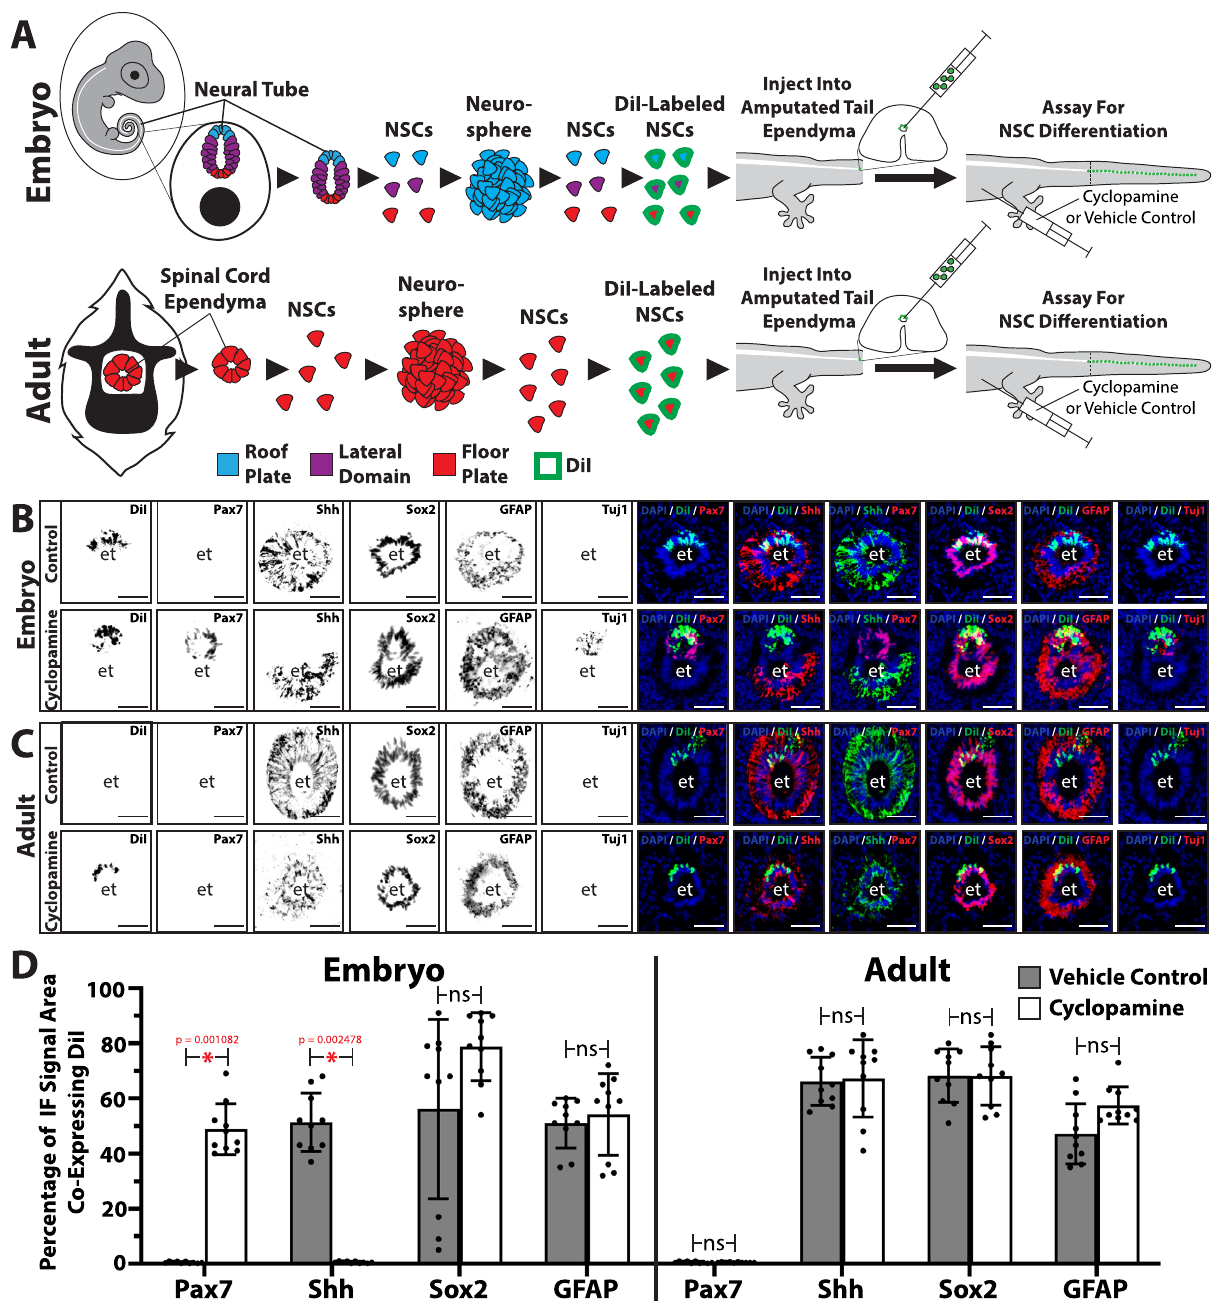
Fig. 6 Embryonic lizard tail NSCs introduced into adult tails contribute to the regenerated ETs and are ventralized by the native Hedgehog signaling environment. A Experimental scheme for introducing embryonic and adult NSCs into regenerated tail ETs. NSCs were isolated from embryo NTs and adult spinal cord ependyma, cultured as neurospheres, dissociated and labeled with DiI. DiI-labeled cells were injected into dorsal regions of adult spinal cord ependyma of tails that had been amputated. Lizards were treated with cyclopamine or vehicle control for 4 weeks while tails regenerated. Regrown tails were collected, and the differentiation and patterning of DiI-labeled exogenous cells were analyzed. B , C Cross sections of ETs of tails grown from stumps implanted with B embryonic or C adult NSCs. For each type of NSC, images of tails treated with vehicle control are depicted in rows on top of cyclopamine- treated tail images. For all rows, individual signal channels are presented to the left, and merged images of select channels are presented on the right. et ependymal tube. Bar = 100 µ m. D Quanti fi cation of exogenous embryonic and adult NSC differentiation in response to treatment with cyclopamine in vivo. Embryonic and adult NSCs pre-labeled with DiI were injected into dorsal regions of tail spinal cord ependyma. Following amputation and treatment with vehicle control or cyclopamine for 28 days, regenerated tails were collected and processed by histology/IF/ fl orescence microscopy every 1 mm along entire tail lengths. Percentages of DiI + ET areas co-expressing Pax7, Shh, Sox2, or GFAP are presented. n = 10 different animals/tails for each condition. Data are presented as mean values + / − SD. Two-way ANOVA with pairwise Tukey ’ s multiple comparison tests was used. * p < 0.01 compared to corresponding vehicle control conditions; ns, not signi fi cant. Source data are provided as a Source data fi